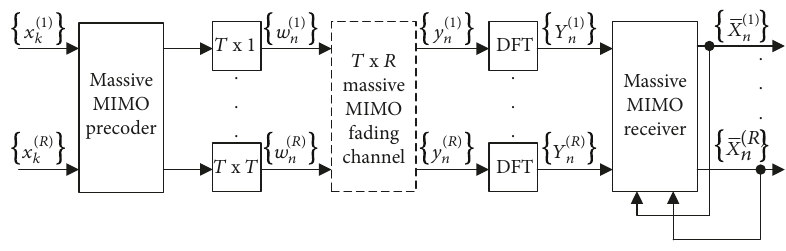
Figure 1: Block diagram of SC-FDE m-MIMO using a